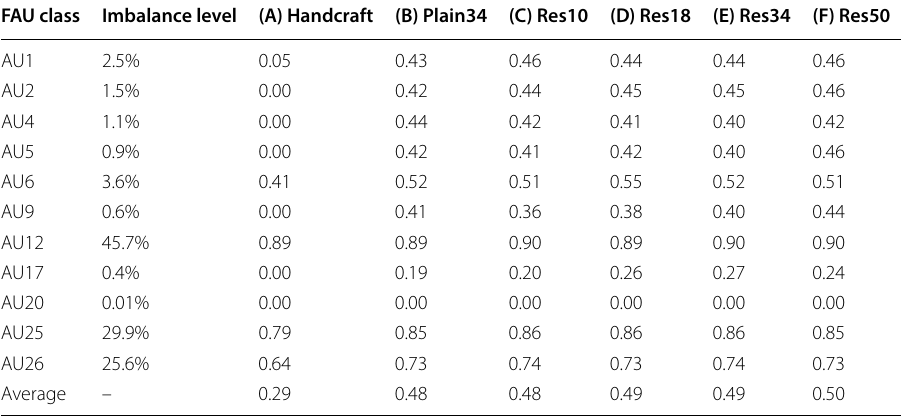
Table 12 Comparing very-deep CNNs on FAU recognition (F1-score)